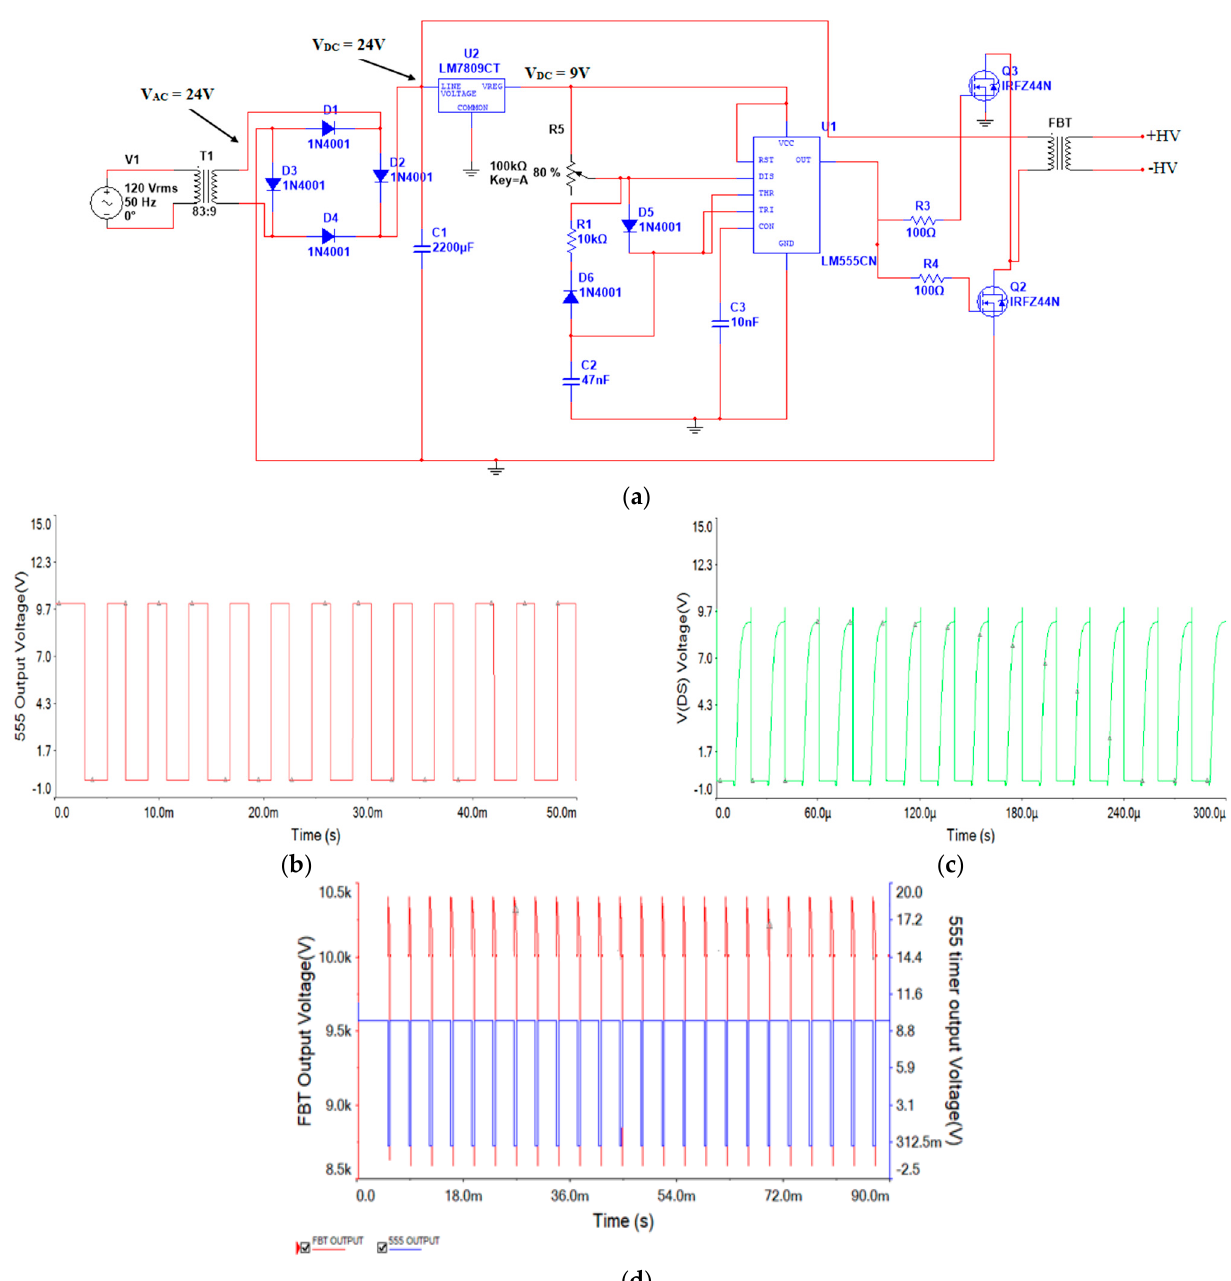
Figure 2 . ( a ) Circuit diagram of high-tension pump source; ( b ) pulse width modulation (PWM) output voltage waveform; ( c ) voltage behavior across the drain to source when square wave voltage is applied at the gate of MOSFET; ( d ) output voltage waveform of PWM and flyback transformer.